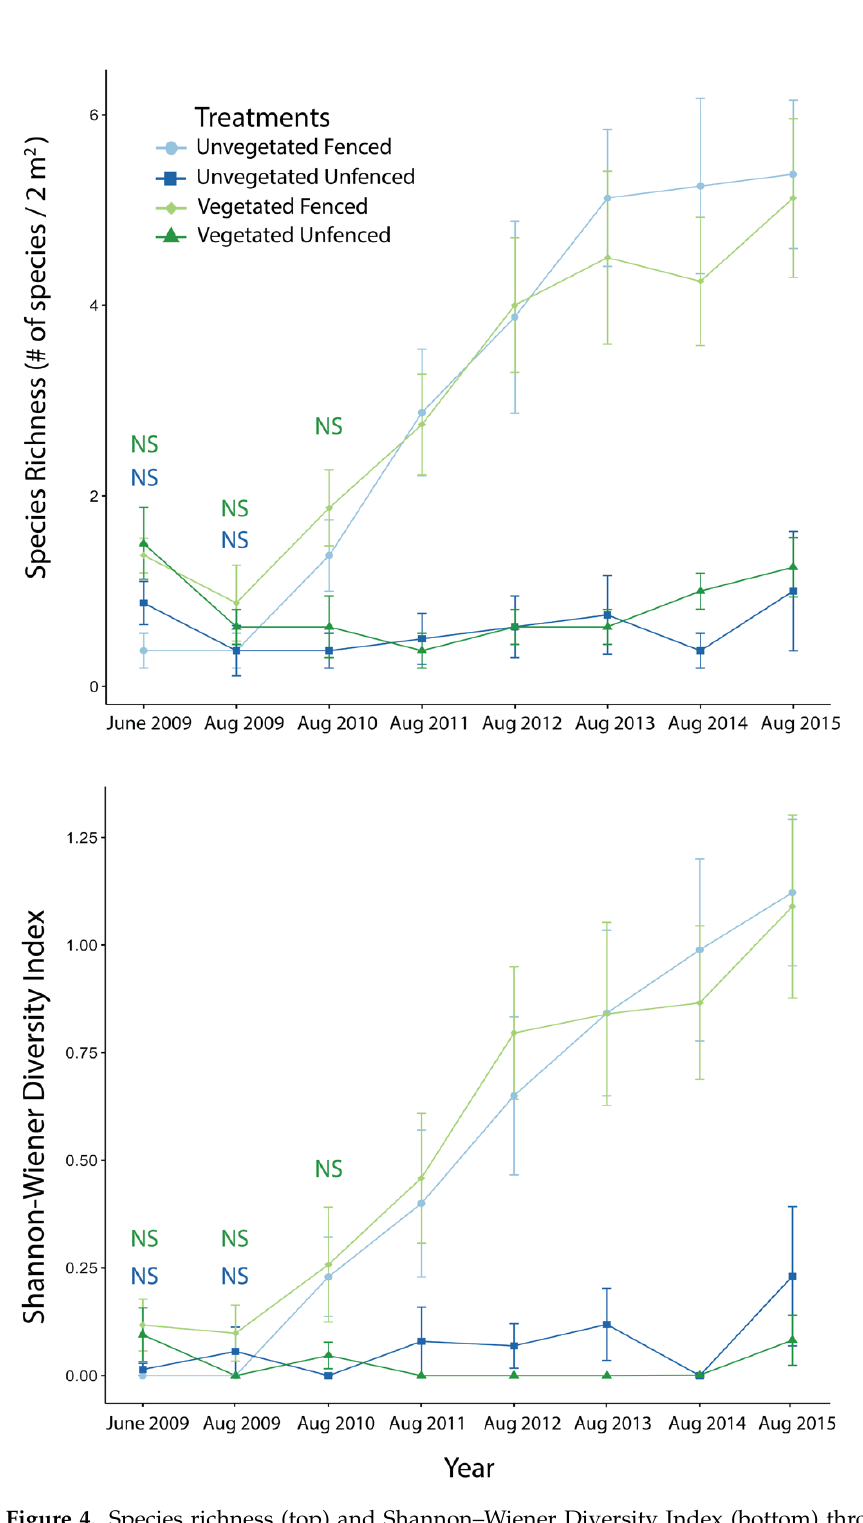
Figure 4. Species richness (top) and Shannon–Wiener Diversity Index (bottom) through time in fenced (lighter colors) and unfenced (darker colors) plots of initially vegetated (green) and initially unvegetated (blue) modules. June 2009 data are included as a baseline; all other data were collected in August to reflect that year’s growing season. Labels of “NS” indicate a non-significant difference between control and exclosure treatments for that sampling date, color-coded to indicate initially vegetated (green) or initially unvegetated (blue) modules; on all other dates, differences were statistically significant. T-test statistics are reported in Table S2. Error bars are standard error.